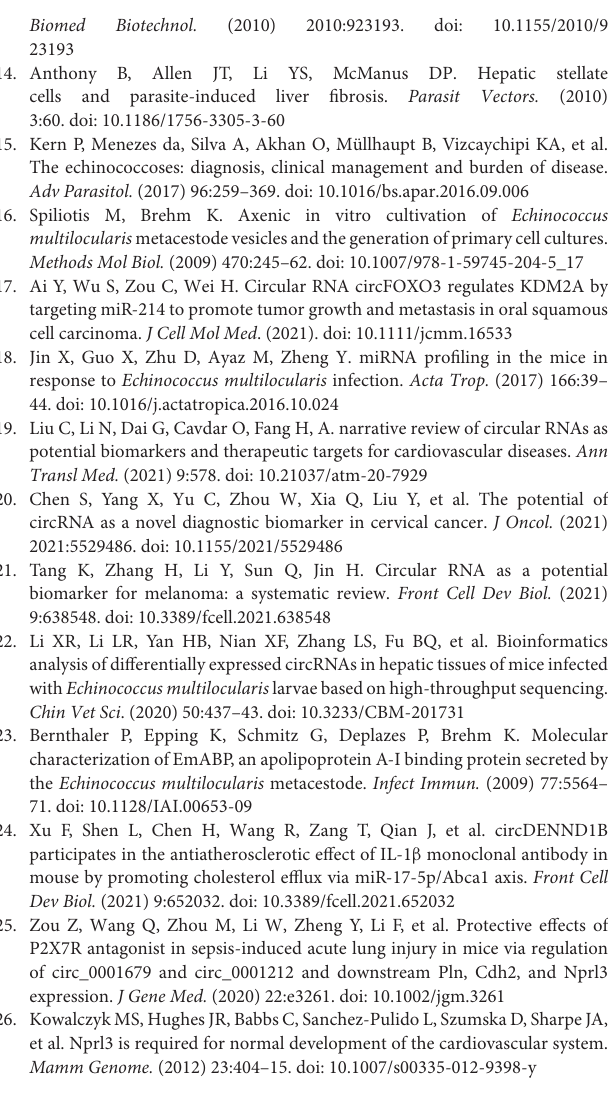
Supplementary Figure S1 | The relative expression level of 8 circRNAs in 2M-HCs, 2M-HSCs, 3M-HSCs, 2M-KCs, and 3M-KCs were determined by qRT-PCR. The number of biological replicates for each experiment was 3, and the relative expression levels were normalized to the expression level of GAPDH. Data are presented as means with SD. P -values were analyzed by Student’s t -test. ∗∗∗ P < 0.001, ∗∗ P < 0.01, and ∗ P <